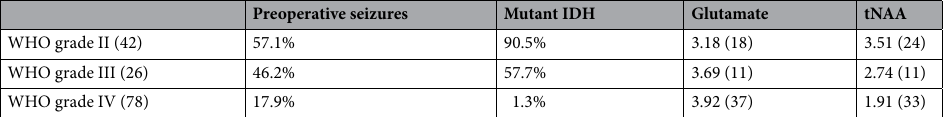
Table 5. Comprehensive data of gliomas in this study including WHO grade, IDH mutation status, and quantified mean values of glutamate and tNAA based on MRS. WHO World Health Organization; IDH, isocitrate dehydrogenase ; tNAA total N -acetyl-l-aspartate. The numbers in the parenthesis indicate the number of analyzed cases.